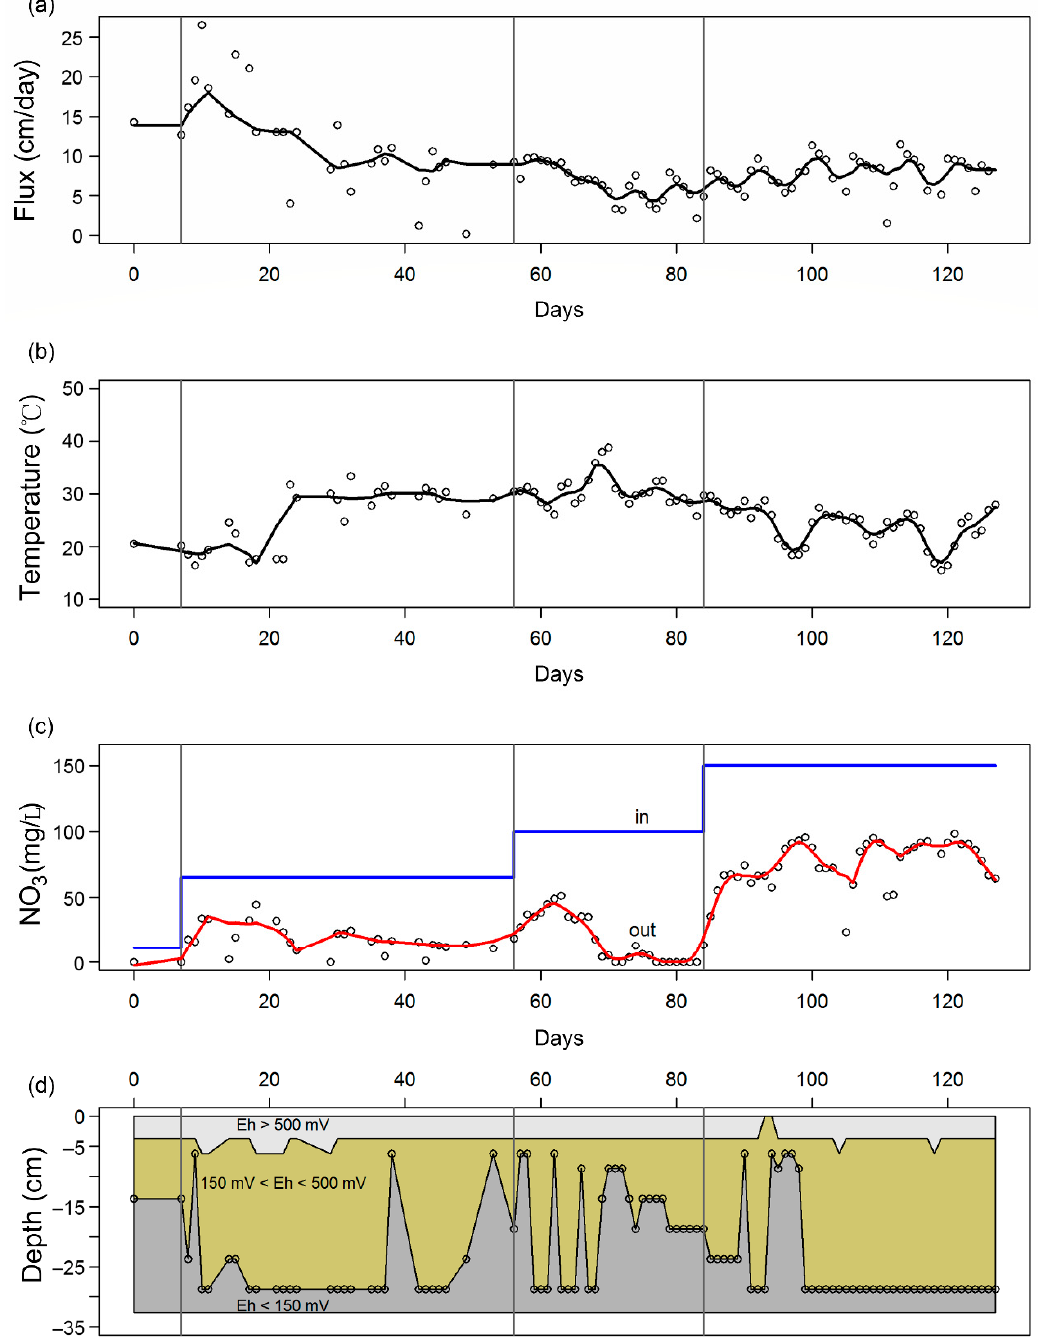
Figure 2. Overview of the flux ( a ), temperature ( b ), nitrate concentration ( c ), and redox potential zone ( d ) of the mesocosm